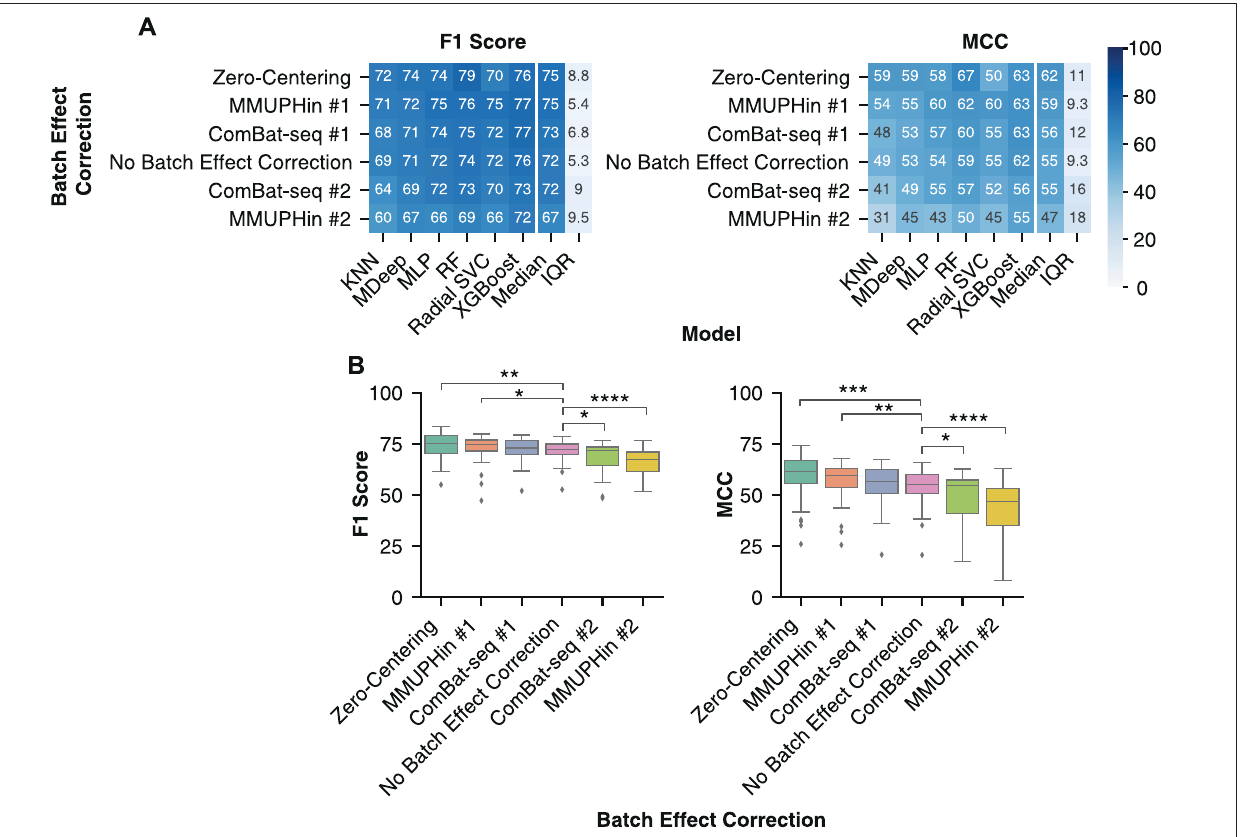
FIGURE 6 | Removing batch effects with zero-centering improved IBD classi fi cation. (A) Median performance of each batch effect correction method across all combinations of normalization or transformation methods, taxonomic features, and non-linear ML models. Rows were sorted in descending order by the median performanceacrossallnon-linearmodels. (B) DistributionofIBDclassi fi cationperformancefollowingbatcheffectcorrectionbythesixdifferentmethods. Allbatcheffect corrections were compared with a Mann-Whitney U test to the No Batch Effect Correction performance and the signi fi cant comparisons were labelled. * indicates p -value < 0.05, ** indicates p -value < 0.01, *** indicates p -value < 0.001, and **** indicates p -value < 0.0001.